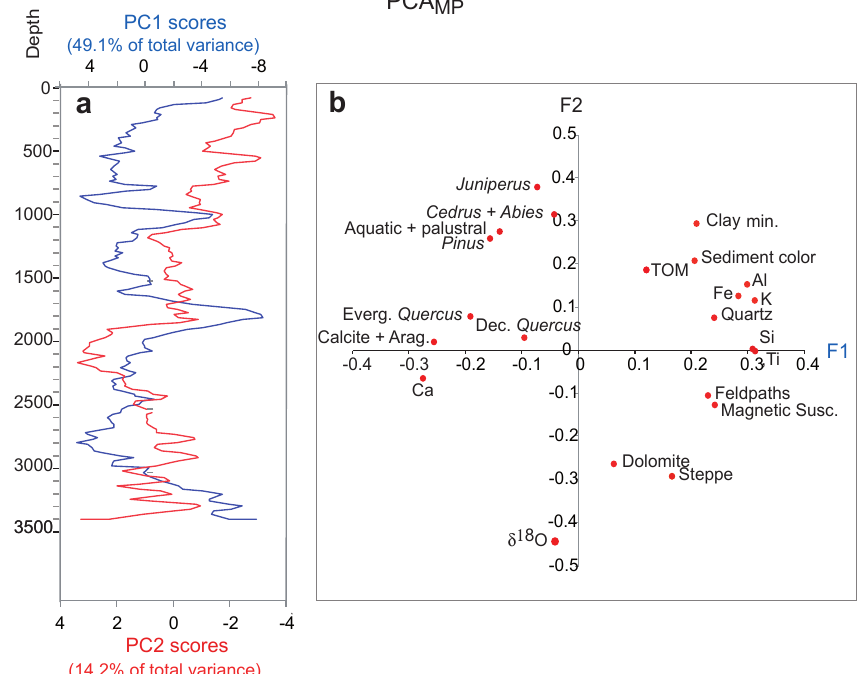
Fig. 8. Principal Component Analysis performed on 22 environmental variables (Tabl 2) in 166 core levels from core YAM04 C’ (ACP MP ). (a) Scores of the 2 first components (PC1 and PC2) versus depth. (b) Projection of environmental variables in the factorial plan